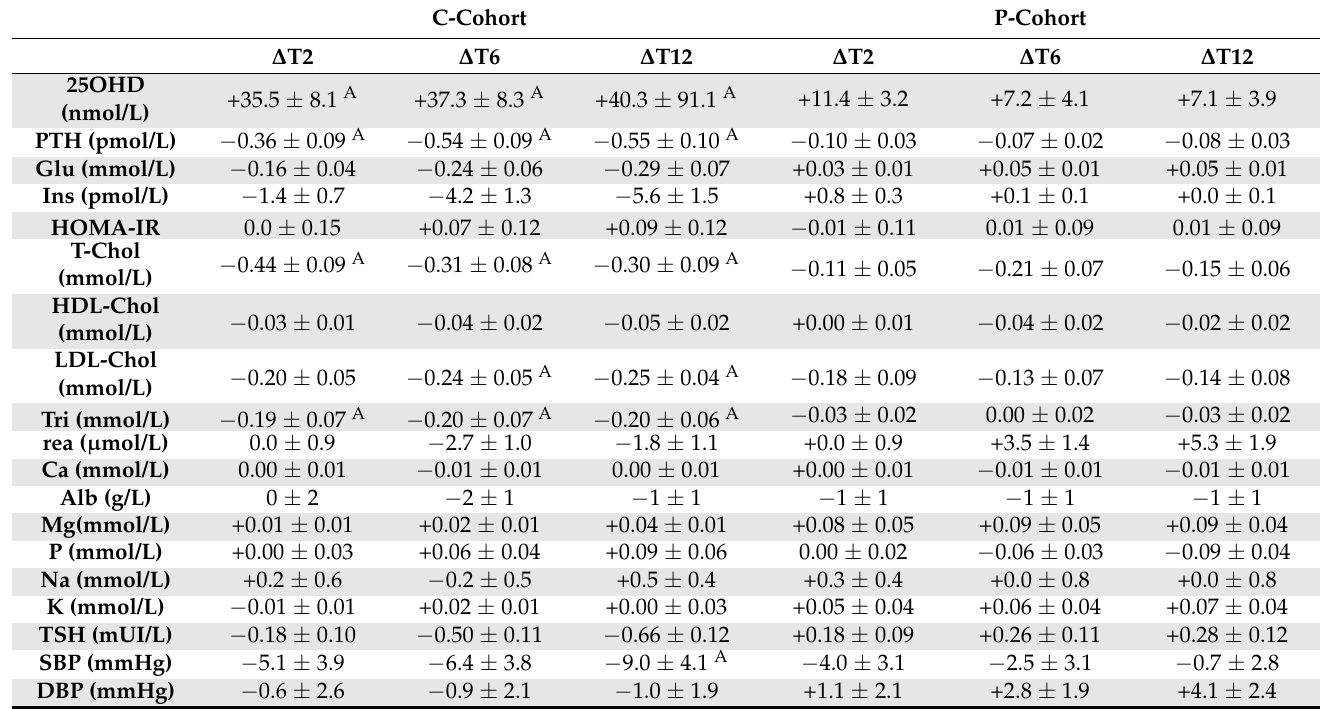
Table 3. Differences from baseline (T0) in the biochemical parameters measured at various time points during the study in the two patient cohorts (expressed as ∆